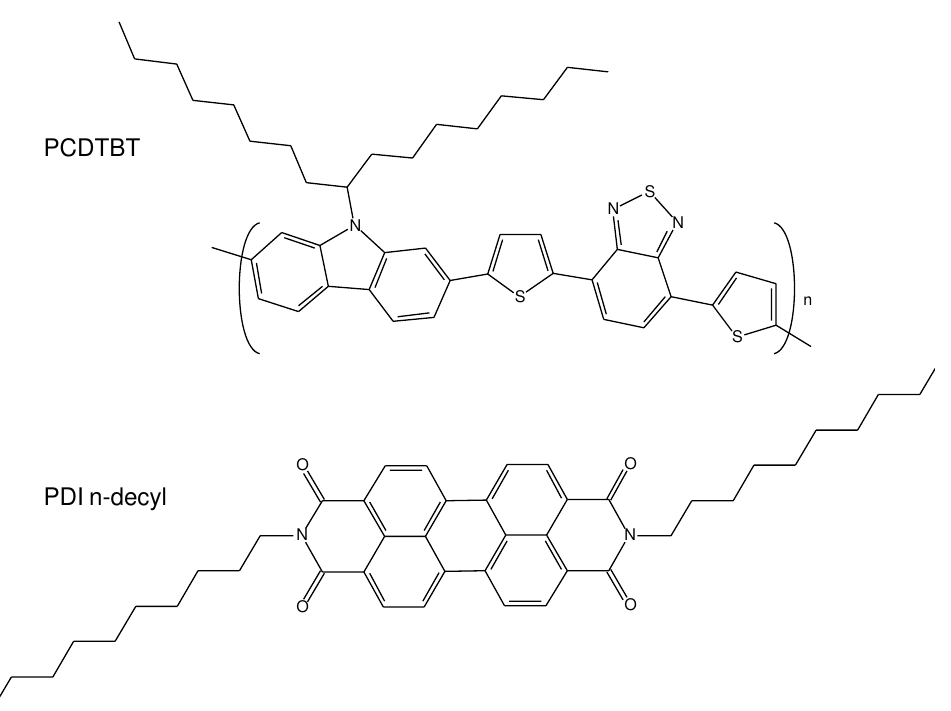
Figure 1. Chemical structures of PDI n-decyl and